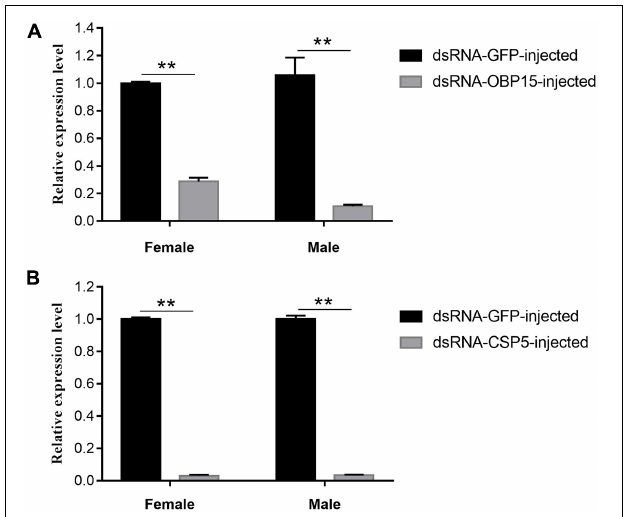
FIGURE 5 | Relative expression levels of GdauOBP15 (A) and GdauCSP5 (B) at 48 h after dsRNA injection in G. daurica antennae measured by qRT-PCR ( t -test; ** P < 0.01). Columns indicate the mean ± standard error of three independent experiments.